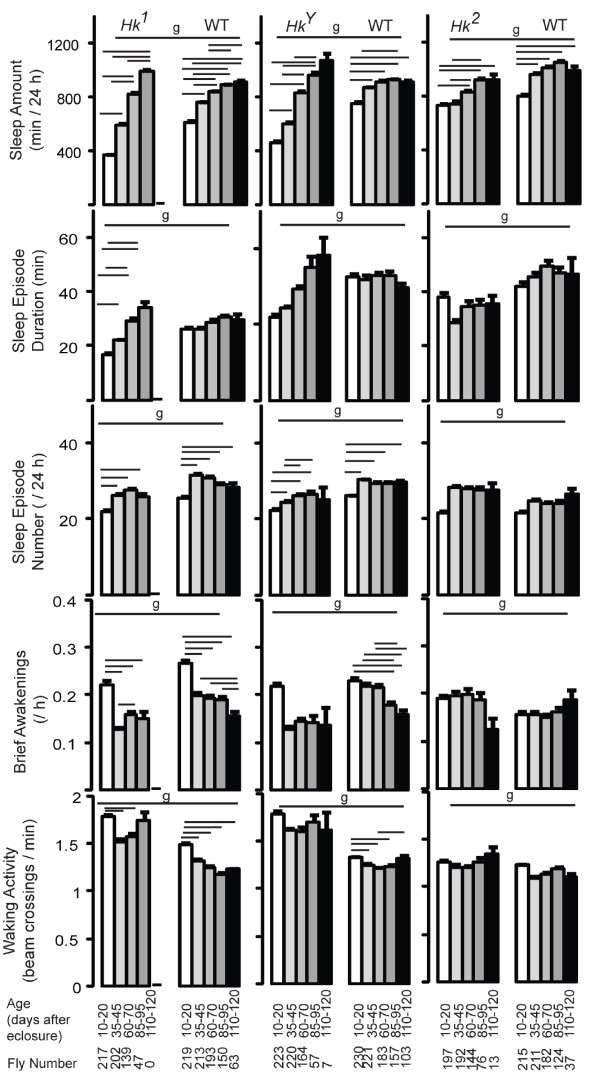
Sleep parameters and waking activity at different ages in all flies. For each age range (from 10 to 120 days; shown below each bar) mean values (+ SEM) were averaged across eleven 24-hour intervals per each fly, and then averaged across all flies. The number of flies tested at each age is indicated below each bar. Genotype (g) effects were tested across all ages (Kruskal-Wallis test, p < 0.05). Horizontal bars indicate significant age-related effects within each genotype (Friedman test followed by Wilcoxon signed-rank test, p < 0.05).